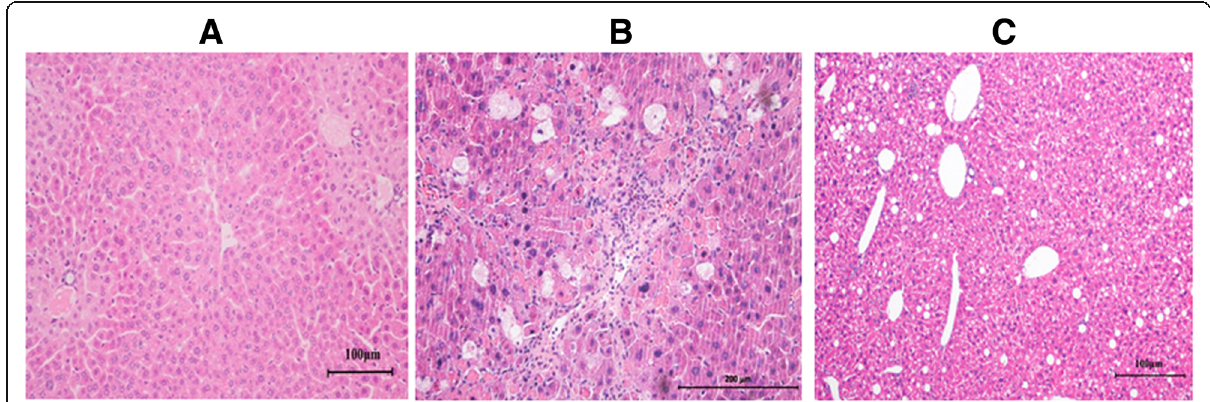
Fig. 1 The Alisma and Rhizoma decoction lessens NASH-like changes in mice. Mice were randomized to receive the regular diet and 2 mL distilled water ( a ), the methionine and choline diet (MCD) and 2 mL distilled water ( b ), or the MCD and 2 mL Alisma and Rhizoma decoction